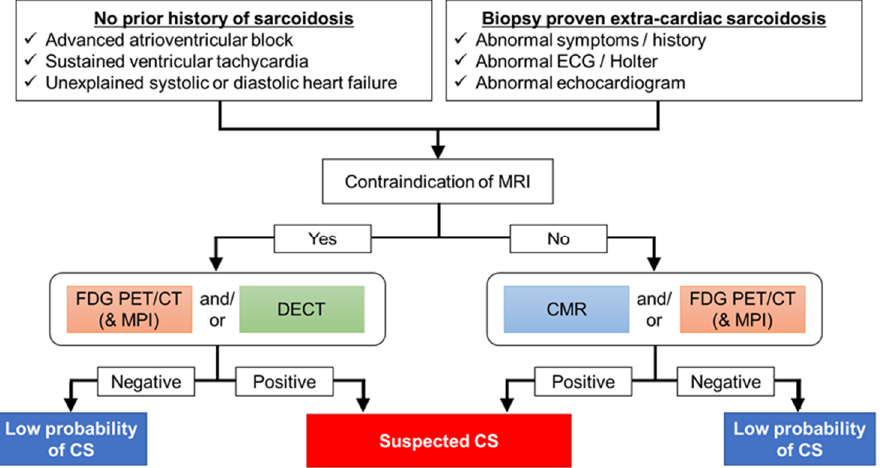
Figure 7. Diagnostic algorithm for a patient with suspected cardiac sarcoidosis. Both cardiac MRI and FDG-PET scans are effective in patients with suspected cardiac sarcoidosis. These scans are sometimes difficult to perform and interpret accurately unless the experts understand the potential pitfalls and artifacts. It is important to differentiate CS from other cardiac diseases such as coronary artery diseases, which might be false-positive for FDG-PET and CMR. Therefore, it is necessary to select the appropriate diagnostic protocol for each facility. FDG-PET should be considered to assess inflammatory activity before initiating anti-inflammatory therapy. In patients with implantable devices, PET would be the first choice. For detection of late enhancement, delayed iodine enhanced CT would be one option for the evaluation of coronary artery disease, systemic disease, and cardiac involvement in patients with sarcoidosis.